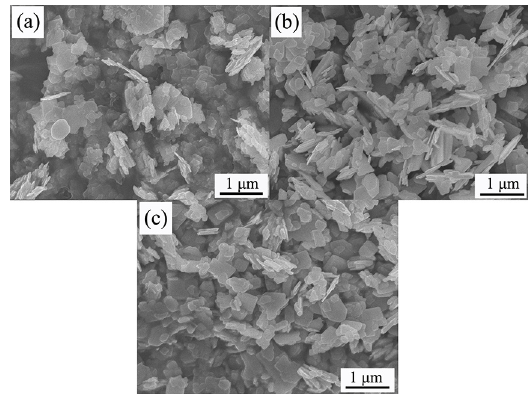
MoO synthesized at (a) 140 ºC, (b) 2 6